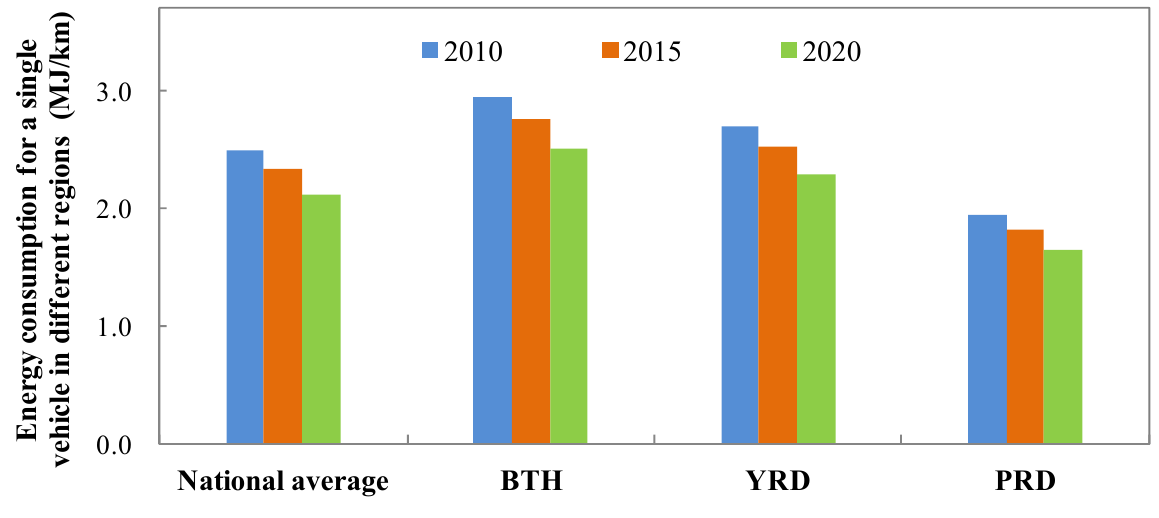
Figure 3. Energy consumption for a single EV in different regions of China.